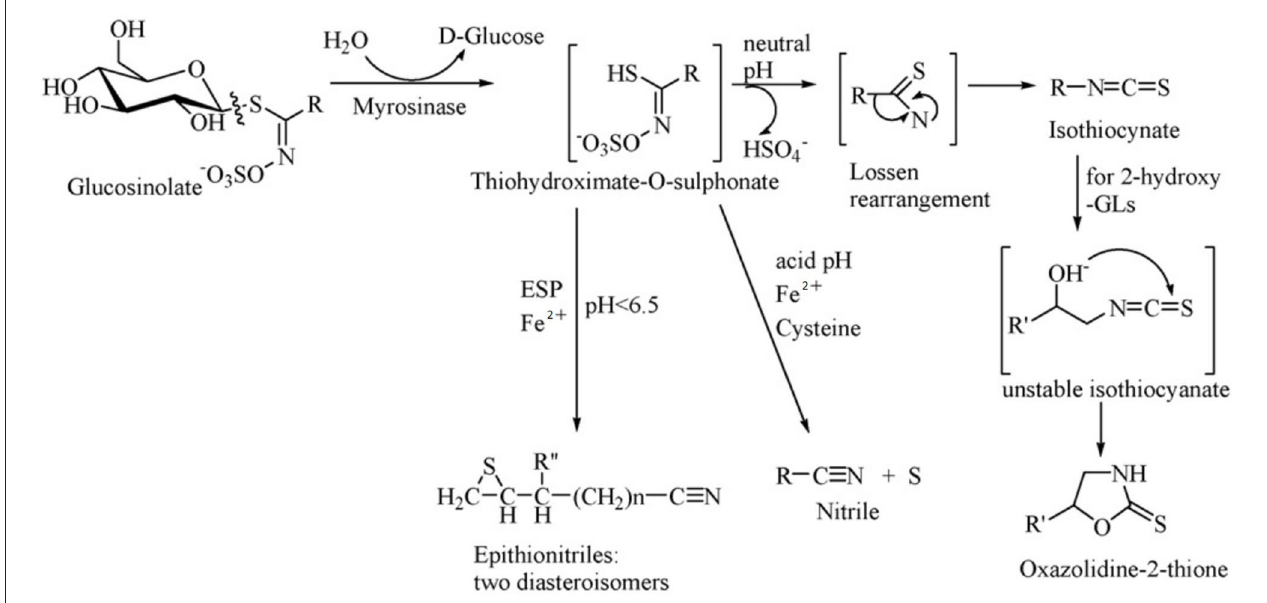
FIGURE 2 | Diagram of enzymatic hydrolysis of glucosinolates. Adapted from Tripathi and Mishra (56).